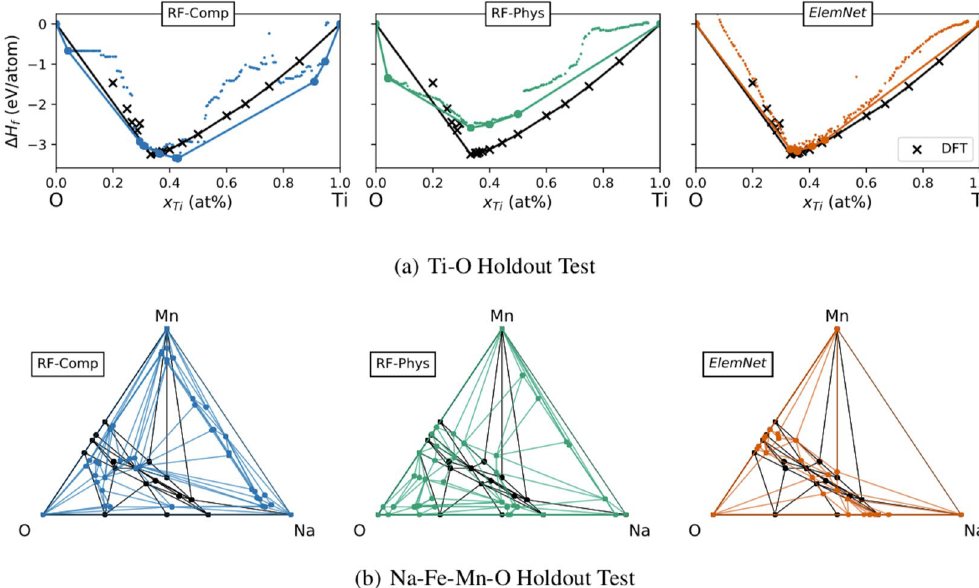
Figure 5. Predicted phase diagrams from the hold-out test. These charts show the convex hulls predicted for the ( a ) Ti-O binary and ( b ) Na-Mn-O from ML models that were trained without any data from each system in their training set. We compare the performance of a Random Forest model trained using only element fractions (RF-Comp), RF trained using physical features (RF-Phys) and a deep learning model ( ElemNet ). Each vertex on the convex hull corresponds to the composition of a stable compound. The black lines on each chart show the OQMD convex hull. We find that the deep learning model has the fewest predictions outside the regions where compounds are known to form, for both the Ti-O and Na-Mn-O phase